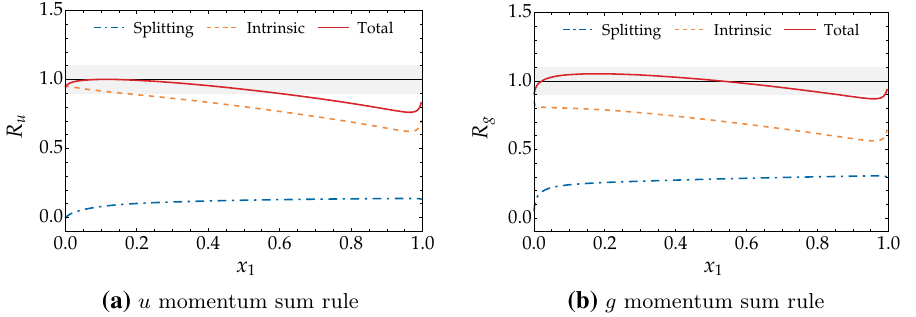
Fig. 1 Momentum sum rule ratios R u and R g for the initial model of Sect. 3, evaluated at the scale μ min = 2 . 25GeV. Shown are the individ- ual contributions from the intrinsic and splitting parts in (17), as well as the full result. The ± 10% deviations from unity are indicated by a light Fig. 2 The momentum sum rule ratio R g for different powers n in the phase space = ( 1 − x − factor ρ a 1 1 a 2 x 2 ) n ( 1 − x 1 ) − n ( 1 − x 2 ) − n of the intrinsic part (9). The case n = 2 is shown in Fig. 1b